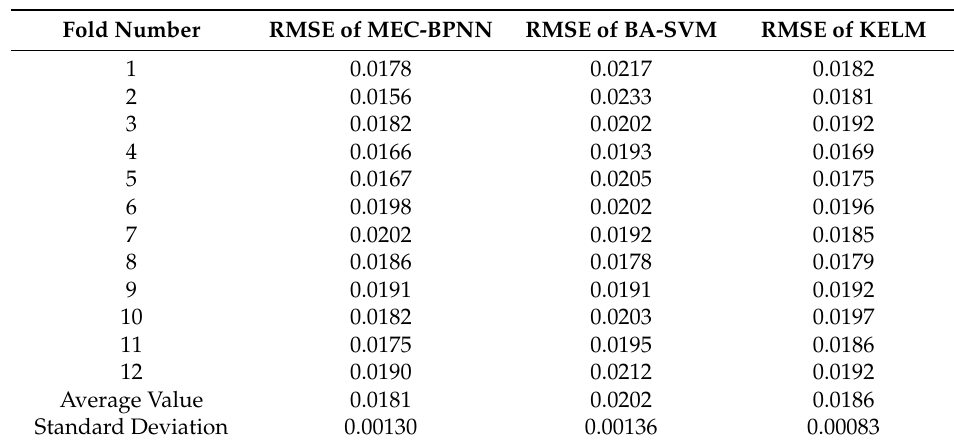
Table 4. Results of the k-fold cross validation.